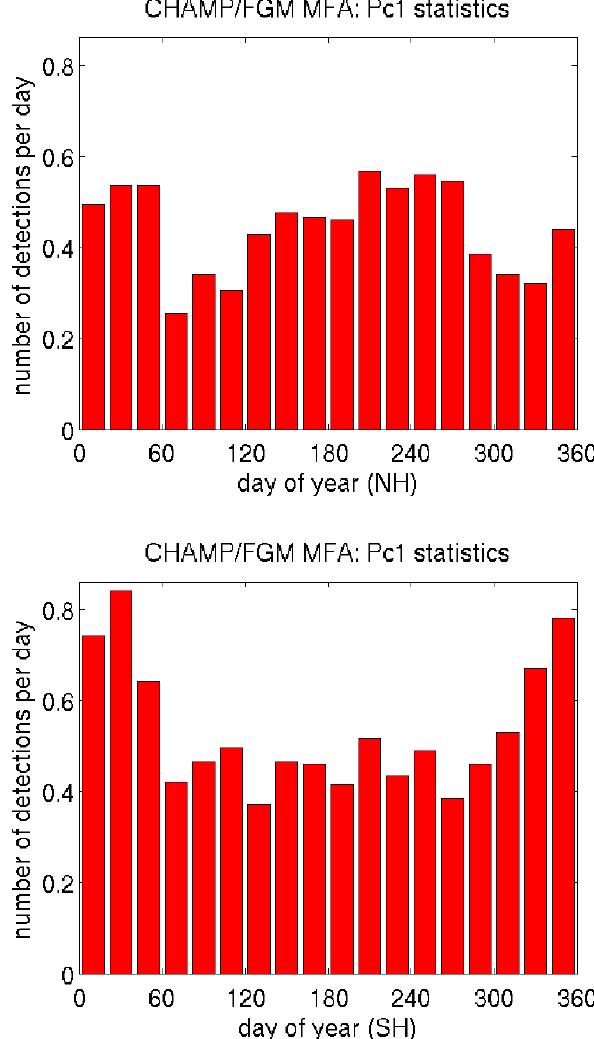
Fig. 4. Diurnal variation of (a) number of detected Pc1 events and (b) Pc1 center frequency. The black dots in (b) show all the Pc1 events, and the red squares represent median values with their range of quartiles shown as dashed lines.